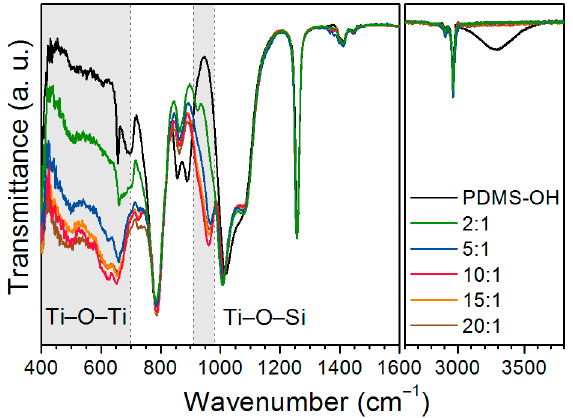
Figure 2. FTIR spectra of Ti-PDMS hybrid materials prepared using PDMS-OH precursors with viscosities of 25 cSt for different TIP/PDMS-OH molar ratios. The spectra are normalized to the Si–CH 3 band at 1260 cm − 1 . Table 1. Assignments of characteristic FTIR and Raman bands of PDMS-OH precursors and Ti-PDMS hybrid materials.